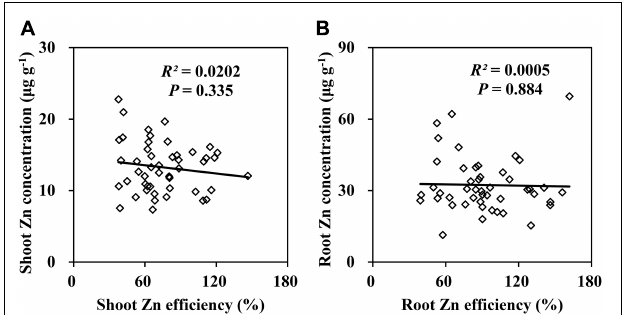
FIGURE 3 | Relationships between Zn efficiencies (ZEs) based on the shoot (A) and root (B) dry weights and Zn concentrations in the shoot (A) and root (B) under Zn deficiency. P < 0.05 indicates significant